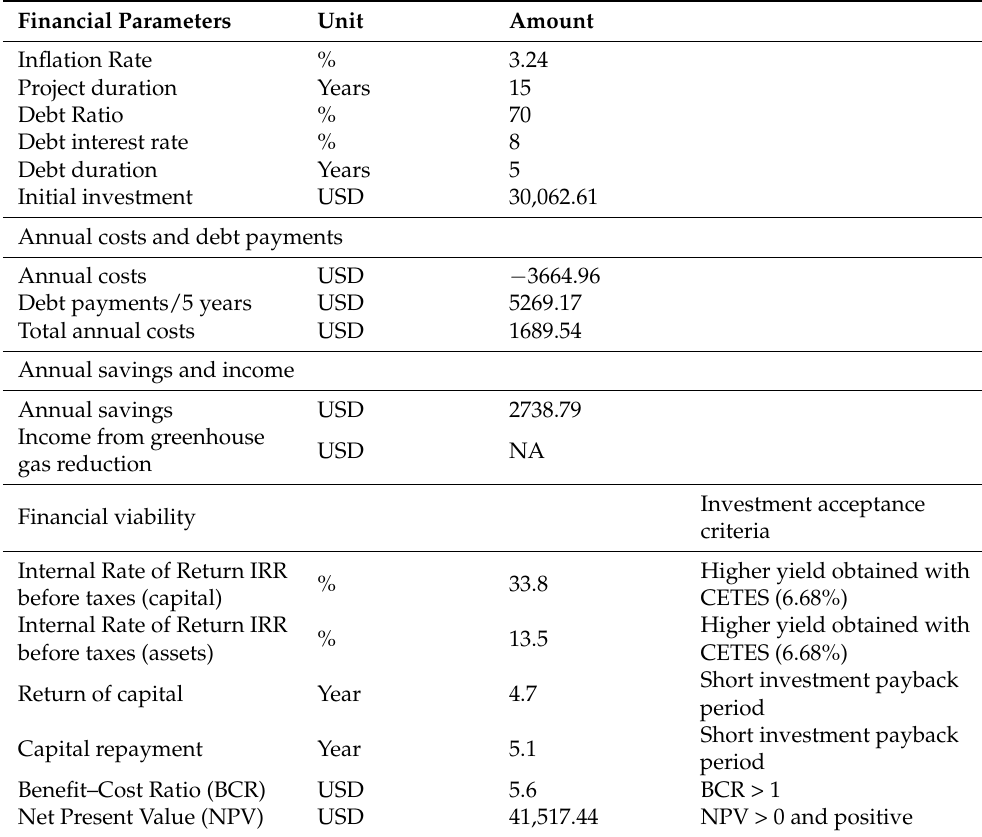
Table 9. Financial results of On Grid-PV systems for Nile Tilapia farm